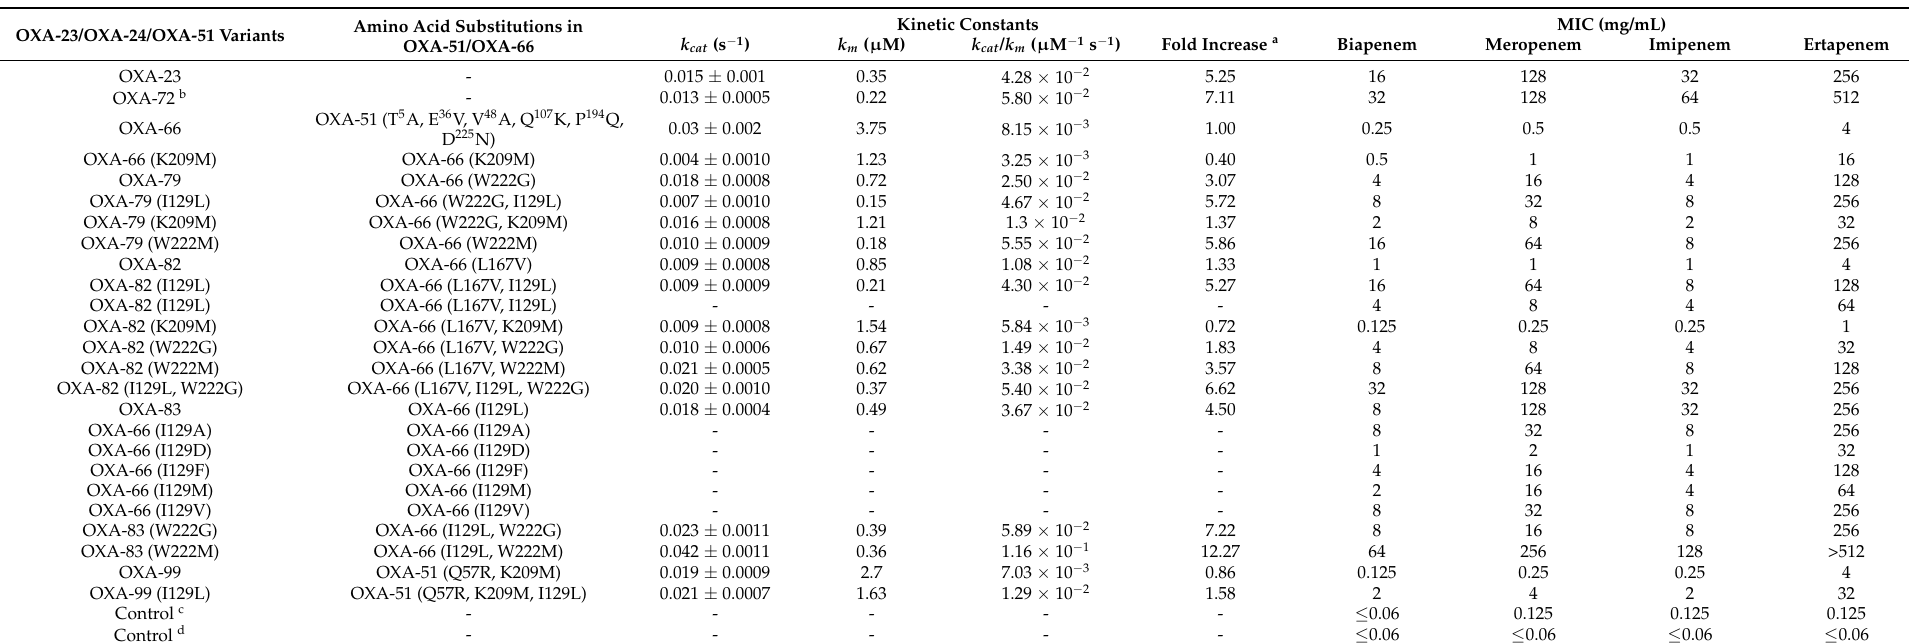
Table 3. Effect of specific amino acid substitutions in OXA-51 variants on their kinetic behavior against different carbapenem and carbapenem MIC in A. baumannii